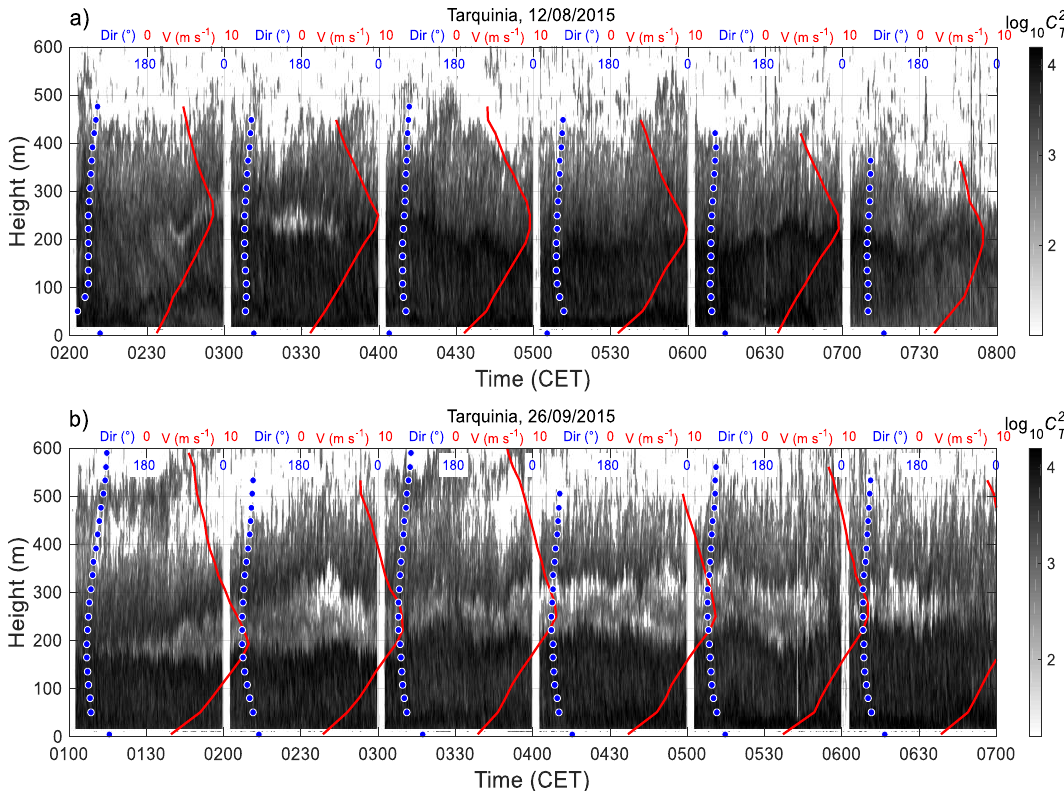
Figure 22. Sodar echograms with superimposed hourly wind speed (red lines) and direction (blue dots) profiles showing LLJ and the presence of Kelvin–Helmholtz billows below and above the LLJ core: ( a ) 12 August 2015 0200–0800 CET and ( b ) 26 September 2015 0100–0700 CET.